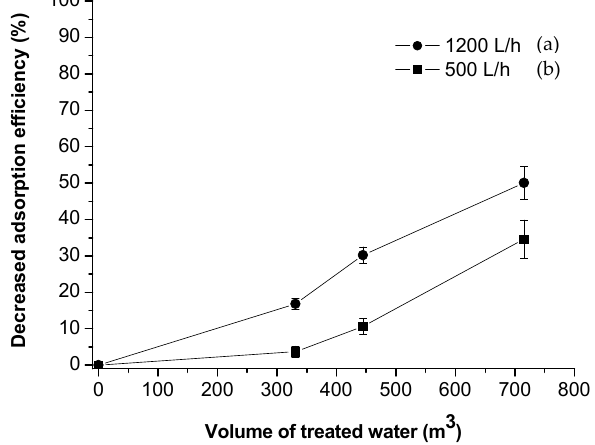
Figure 7. Decrease in adsorption efficiency at different treated wastewater volume in two workflows: ( a ) 1200 L/h, ( b ) 500 L/h.